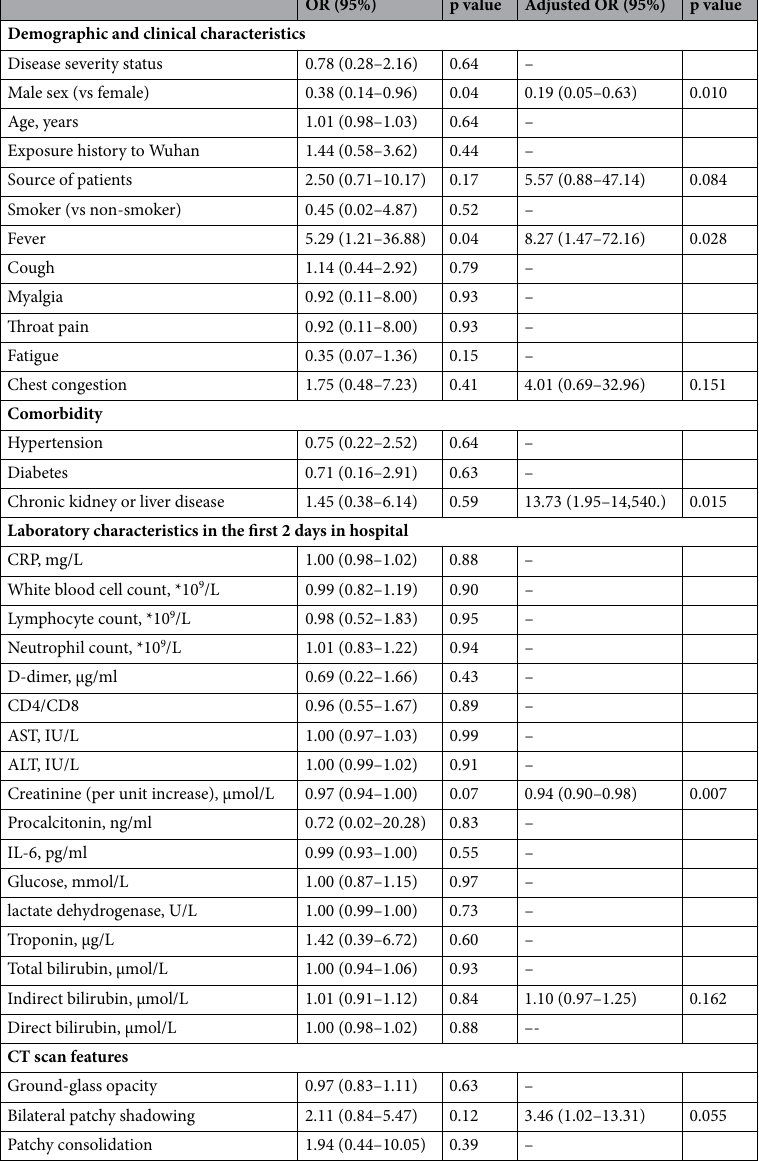
Table 2. Risk factors associated with prolonged hospital LOS. OR odds ratio, 95% CI 95% confidence intervals.